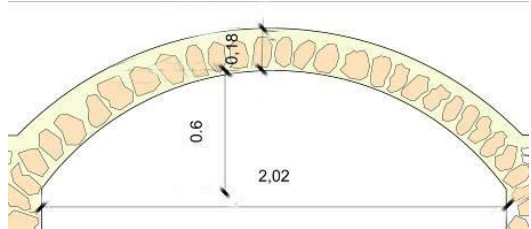
Figure 11. Section of ‘Desert Rose’ stone dome .